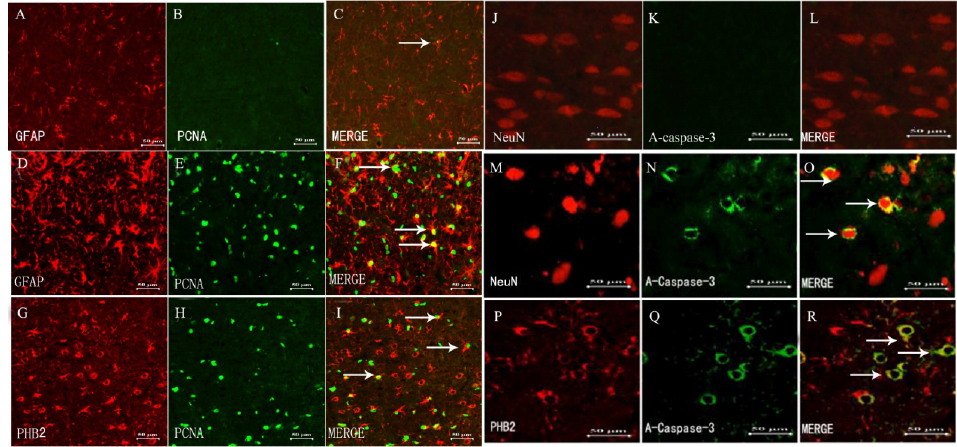
Figure 4. Association of PHB2 with survival and proliferation after TBI. Double immunofluorescence staining was used for PCNA, GFAP, activated caspase-3 and PHB2 in brain cortex after TBI. In adult rat brain at five days after injury or in the sham group, sections labeled with PCNA ( B , D ) and GFAP ( A , C ), and the co-localization of PCNA with GFAP were found in brain ( C , F ); PHB2 positive cells were co-localized with PCNA ( G – I ); Sections labeled with activated caspase-3 ( K , N ) and NeuN ( J , M ), and the co-localization of activated caspase-3 with NeuN were shown in the brain at day five after TBI ( O ); Moreover, coincidence of PHB2 ( P ) with activated caspase-3 ( Q ) were also showed ( R ) by adjacent serial sections. Scale bars: 50 μ m. The white arrows represent the co-expression of